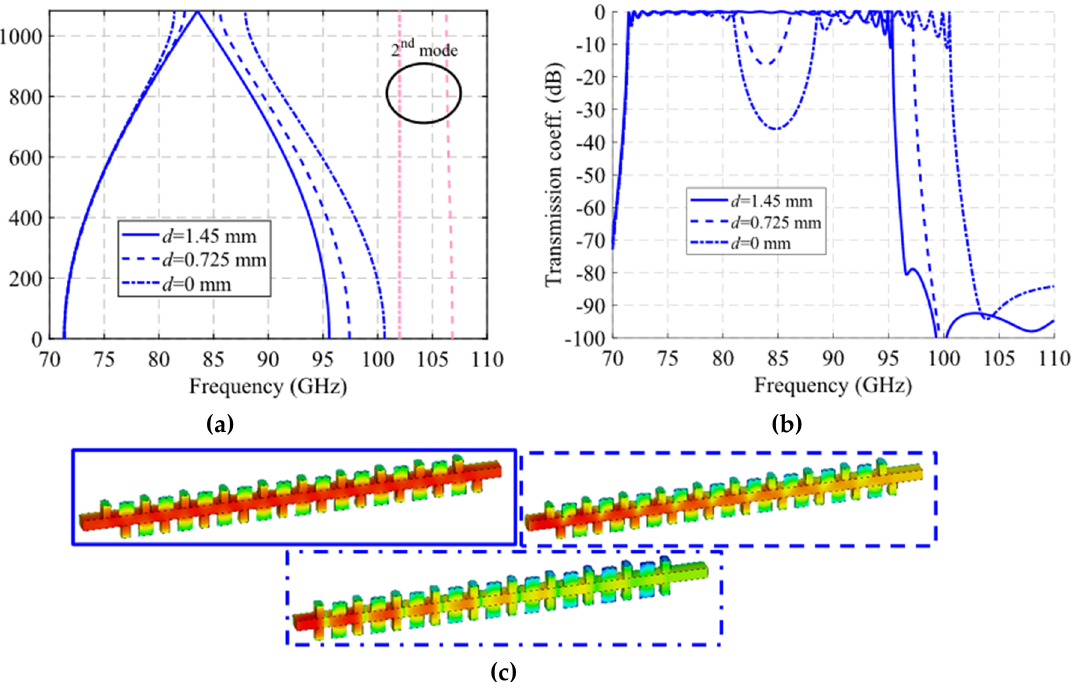
Figure 22. Analysis of the single periodic unit cell for different stages of glide symmetry. ( a ) Phase constant, ( b ) transmission coefficient with N = 10 unit cells and ( c ) electric field level inside the structure at 83.5 GHz.